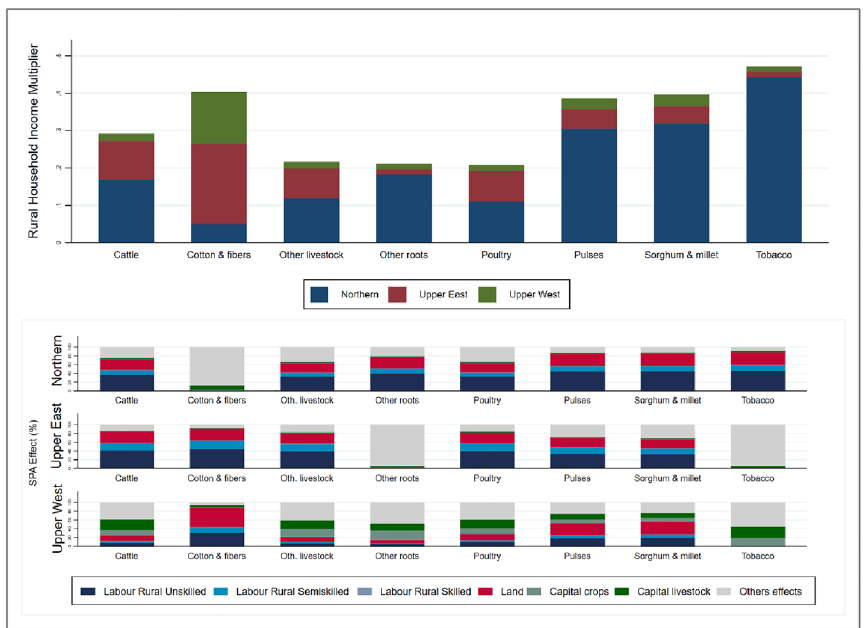
Fig. 5 Top graph: distribution of the rural household income multiplier in the north by each region. Bottom graph: structural path analysis from agricultural commodities to rural households income by the regions in the north (Source: own